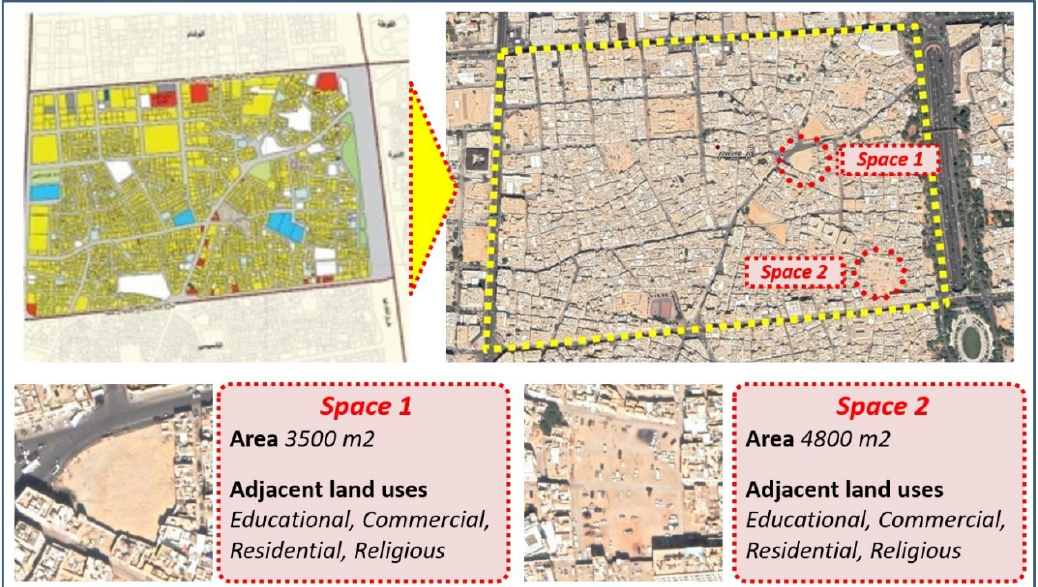
Figure 9. The urban street pattern for District 3 with the potential suitable sensitive spots to apply the UA